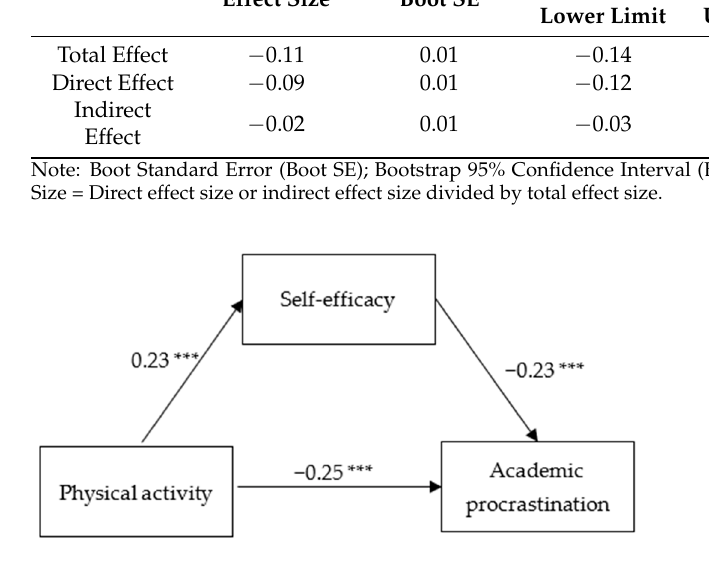
Figure 1. The mediating effect of PA on AP through self-efficacy. Note: *** p < 0.001.